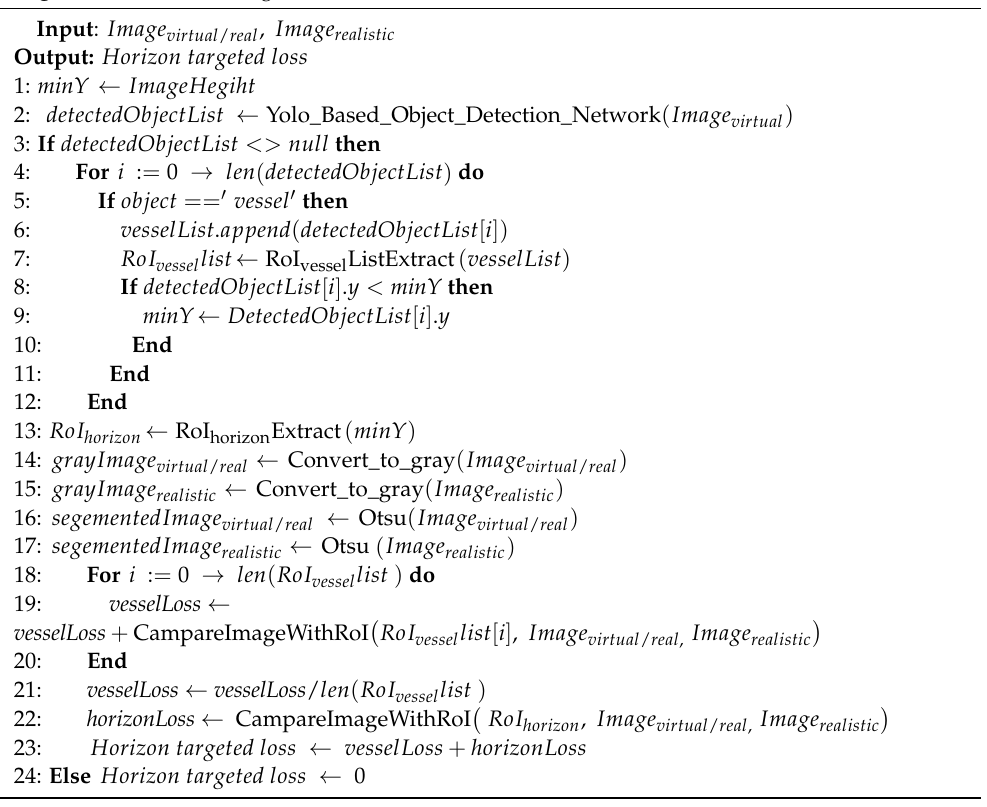
Algorithm 1 Horizon-targeted loss calculation